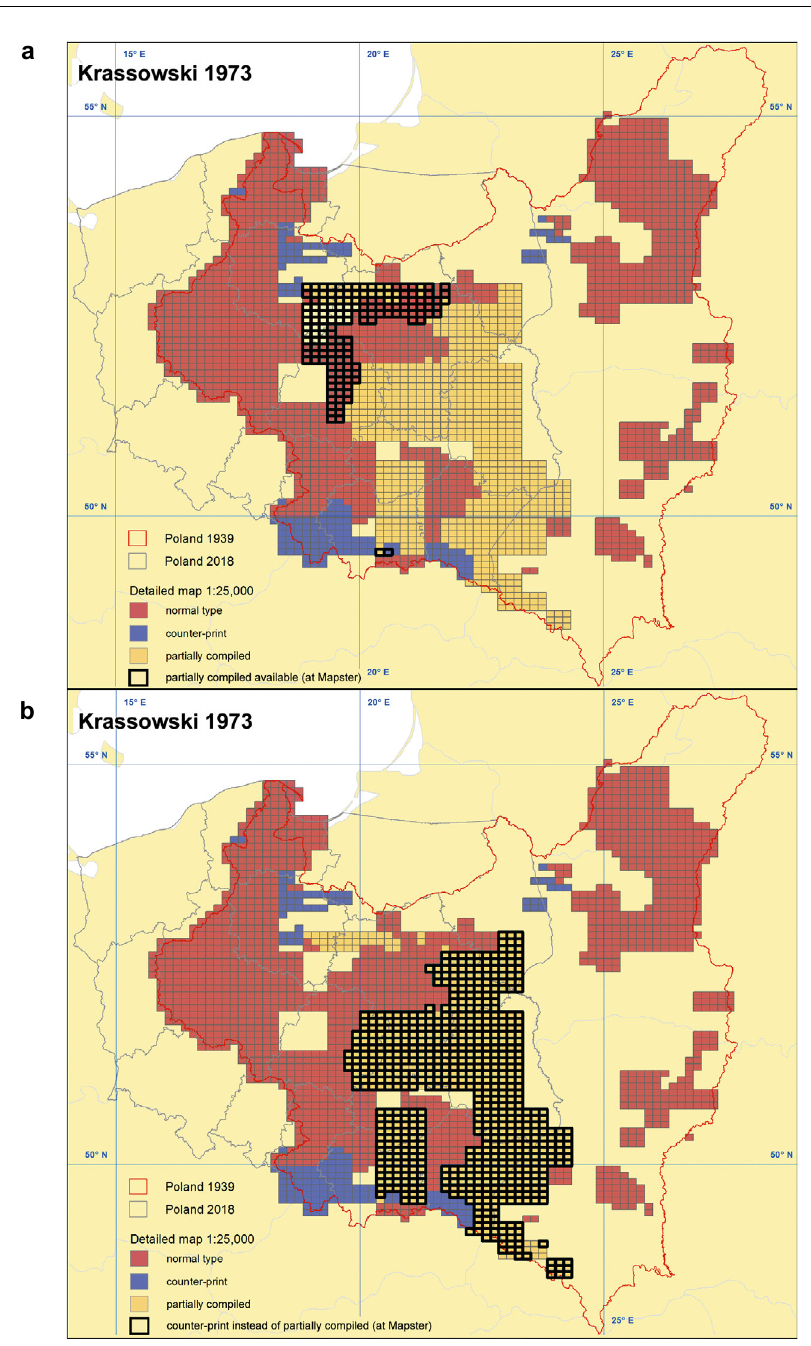
Fig. 4. MGI’s 1:25,000 detailed map sheet types according to B. Krassowski in 1973: a) highlighted sheets are actually ‘partially compiled’ sheets available via Mapster in 2018; b) selected sheets are where Mapster provide counter-prints instead of ‘partially compiled’ sheets (Author’s original